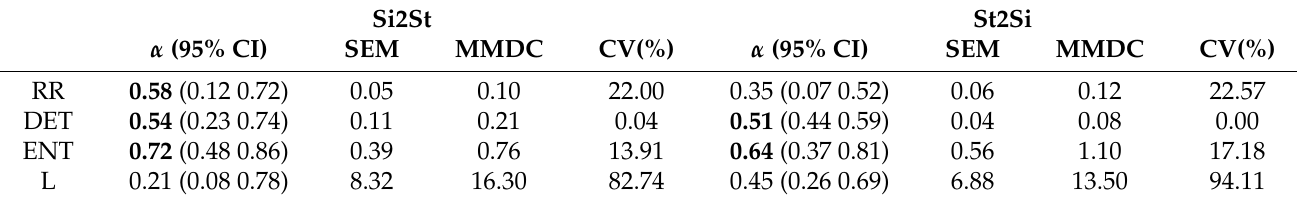
Table 1. Reliability analysis of the RQA measures in the activities of Si2St ( n = 34) and St2Si ( n = 54) for RoomSet1 .